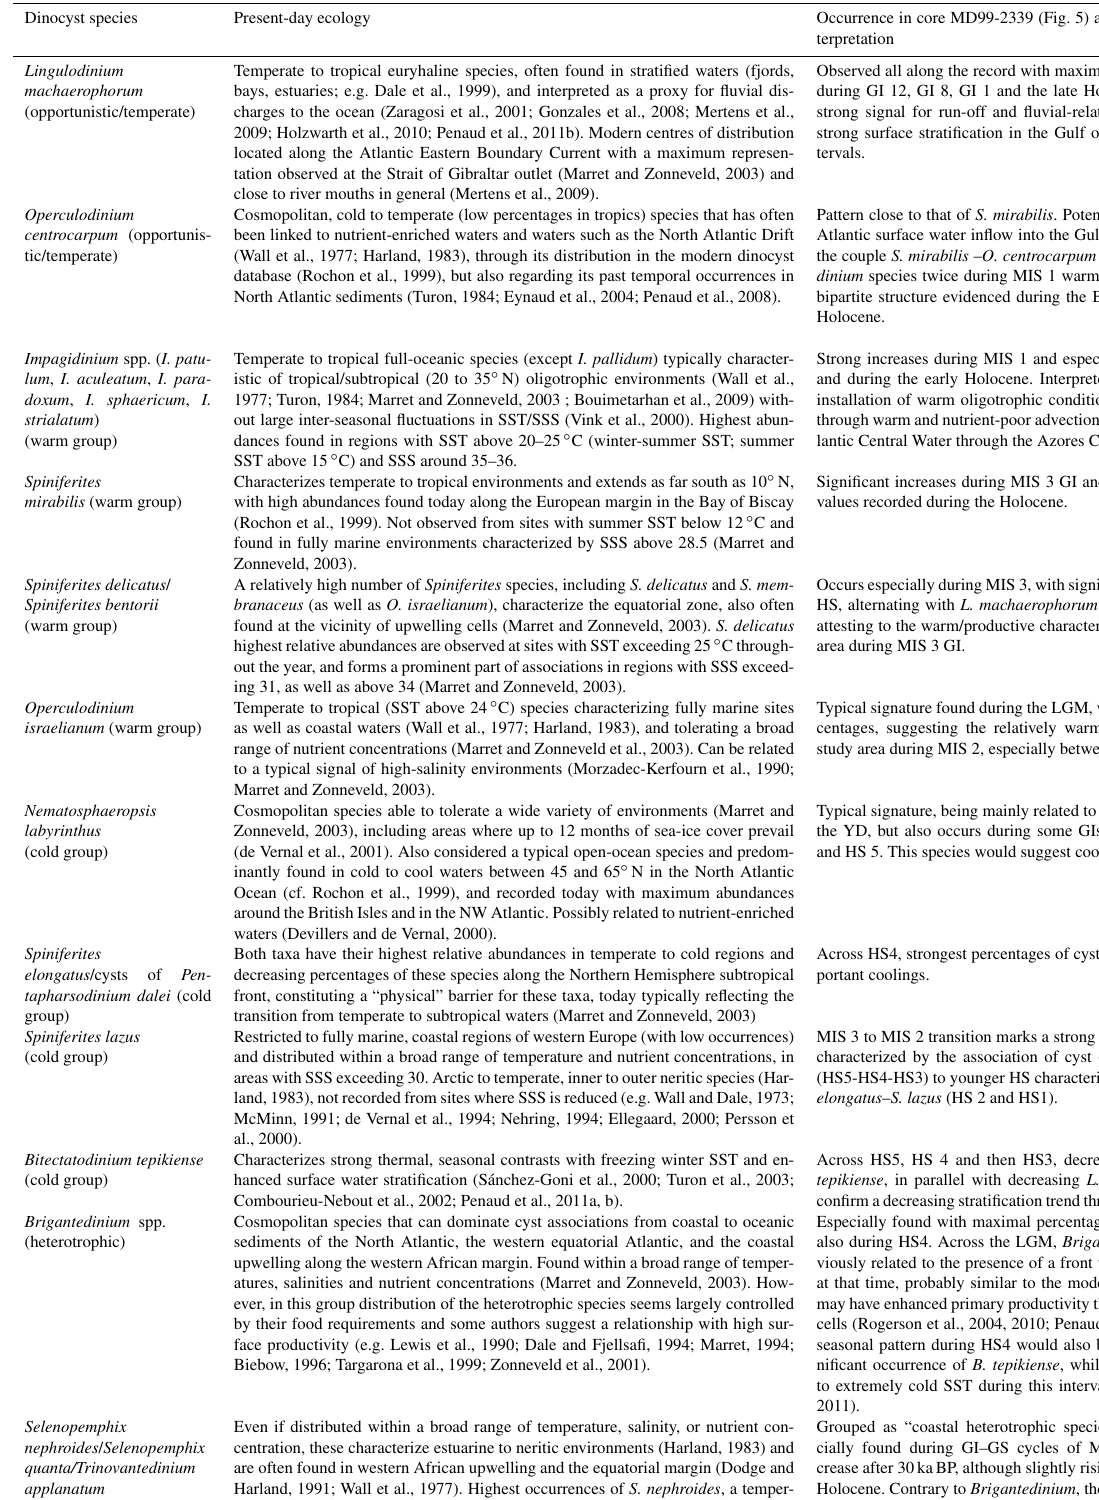
Table 1. Modern distribution versus past occurrences (MD99-2339 record) for selected major dinocyst species found in the fossil assemblage (see Fig.